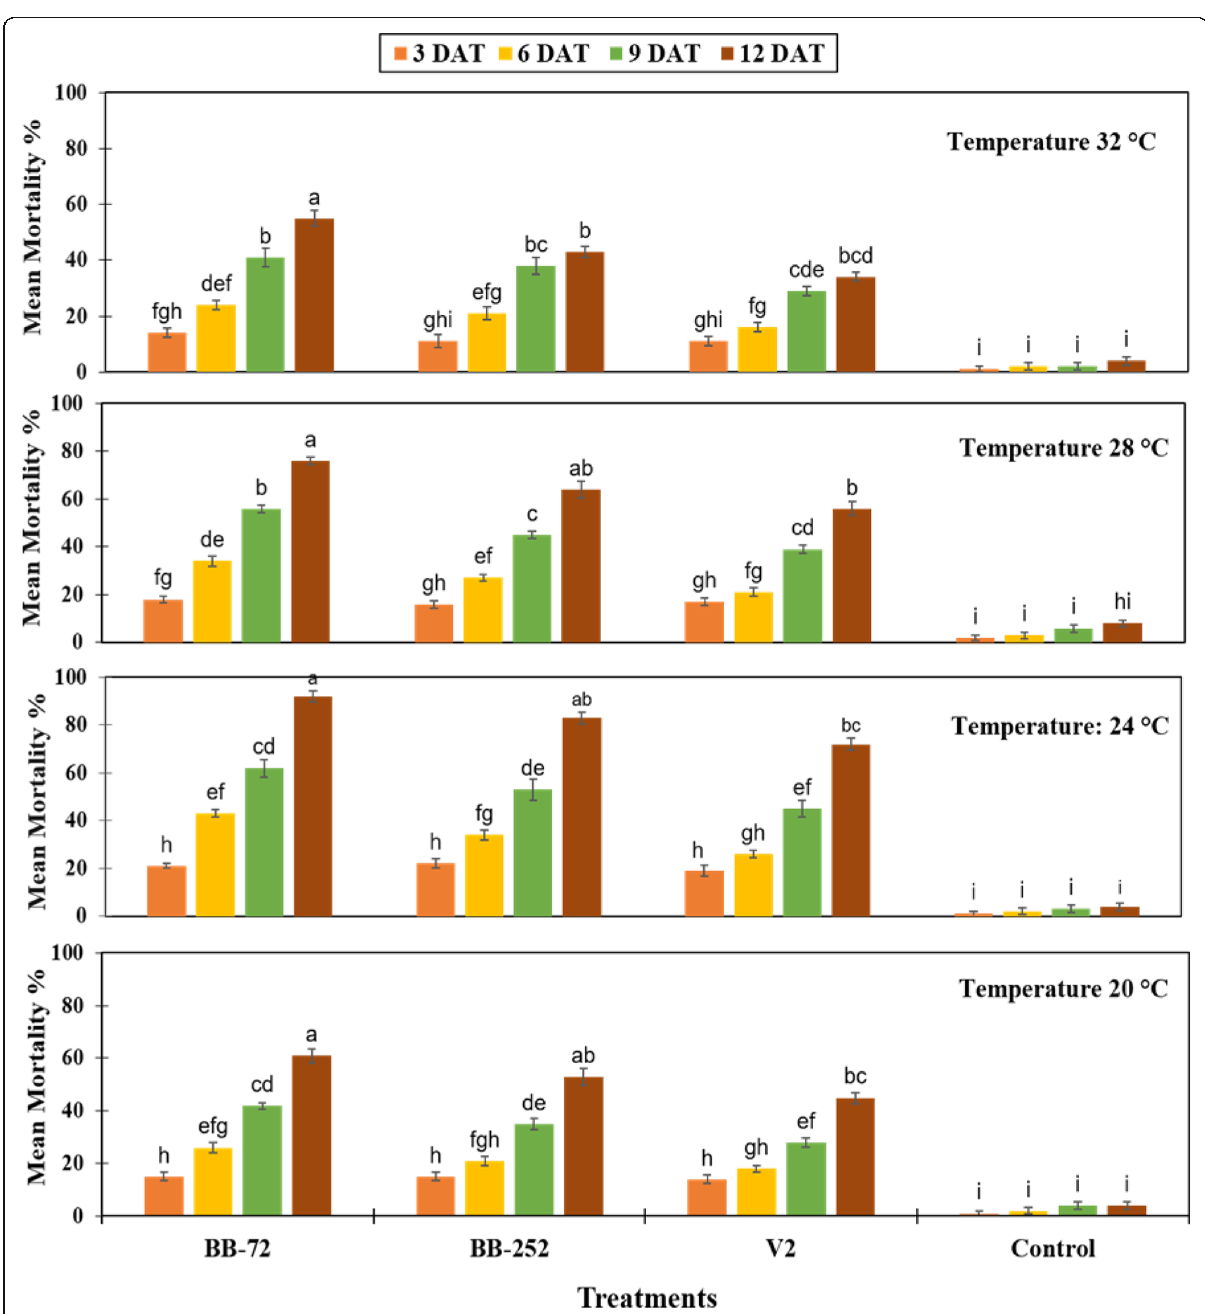
Fig. 2 Mean mortality percentage of Bemisia tabaci recorded at different temperature and different time intervals (DAT: days after treatment) for filtrate bioassays carried out with two strains of Beauveria bassiana (BB-72 and BB-252) and one strain of Lecanicillium lecanii (V-2). Columns represent mean percent mortality ± SE ( n = 10). Treatment columns bearing different alphabets were significantly from other treatments (least significant difference (LSD) test at α =